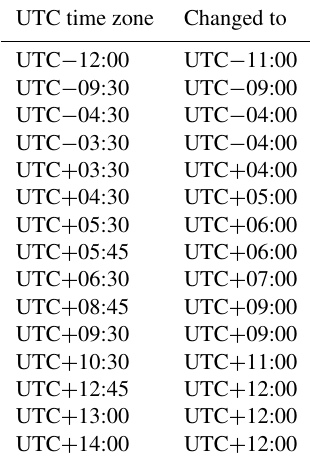
Table A1. UTC time zone adjustments. Table B1. R packages and versions used for the FWI calculation presented in this